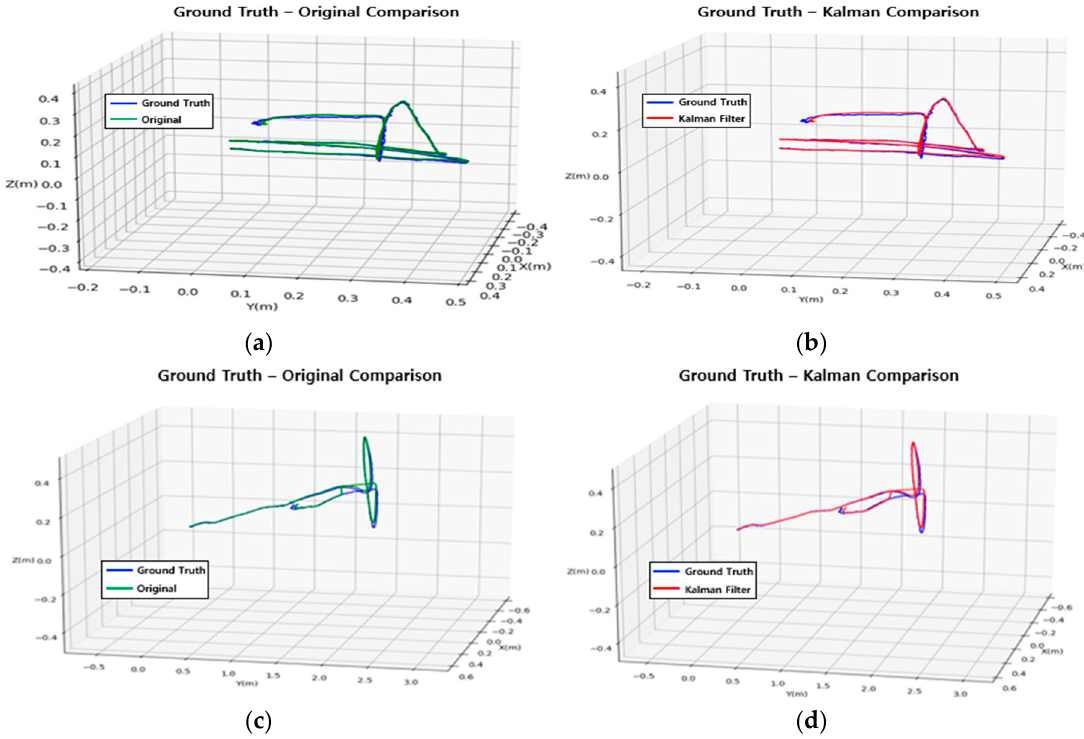
Figure 8. Accuracy evaluation of the camera trajectory extracted from ( a , c ) the ZED and ( b , d ) the applied Kalman filter against the ground truth (Boujou).